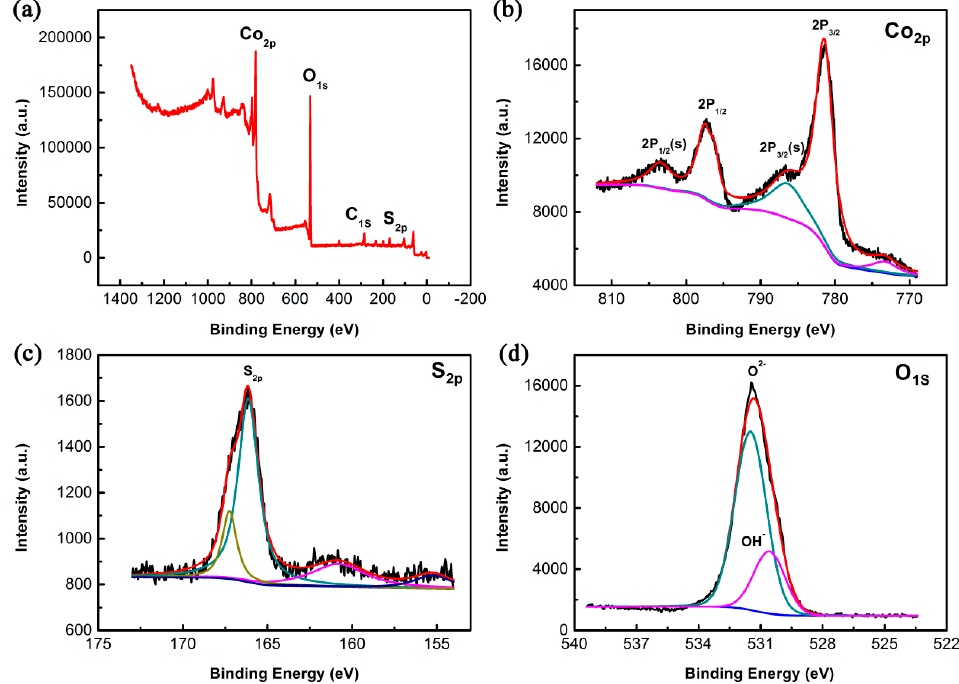
Figure 4. ( a ) XPS survey spectra of composites; ( b – d ) high-resolution XPS survey scan of Co 2p, S